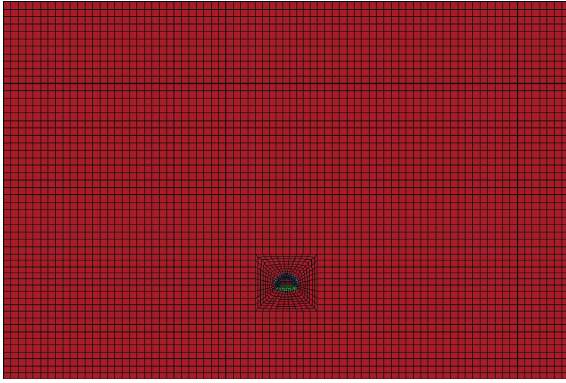
Figure 10: Numerical calculation and analysis model. Table 1: Mechanical parameters value of the surrounding rock. S.